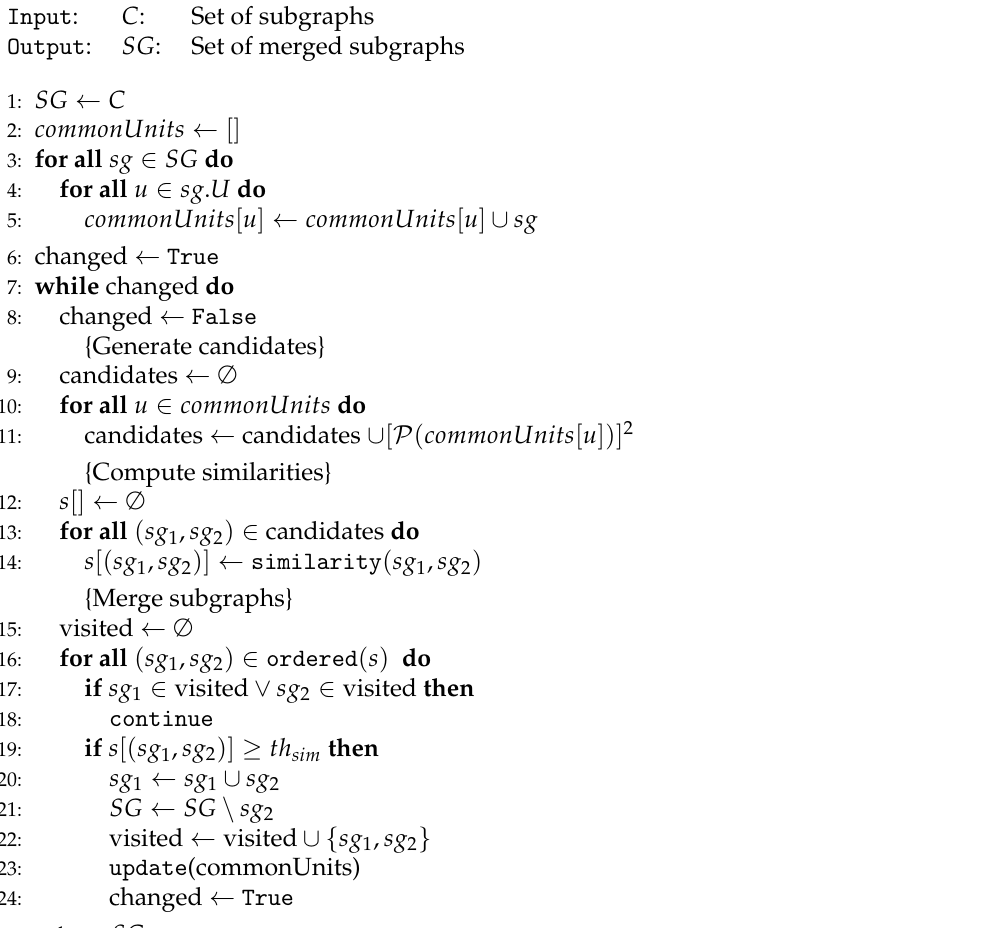
Algorithm 1 Merge